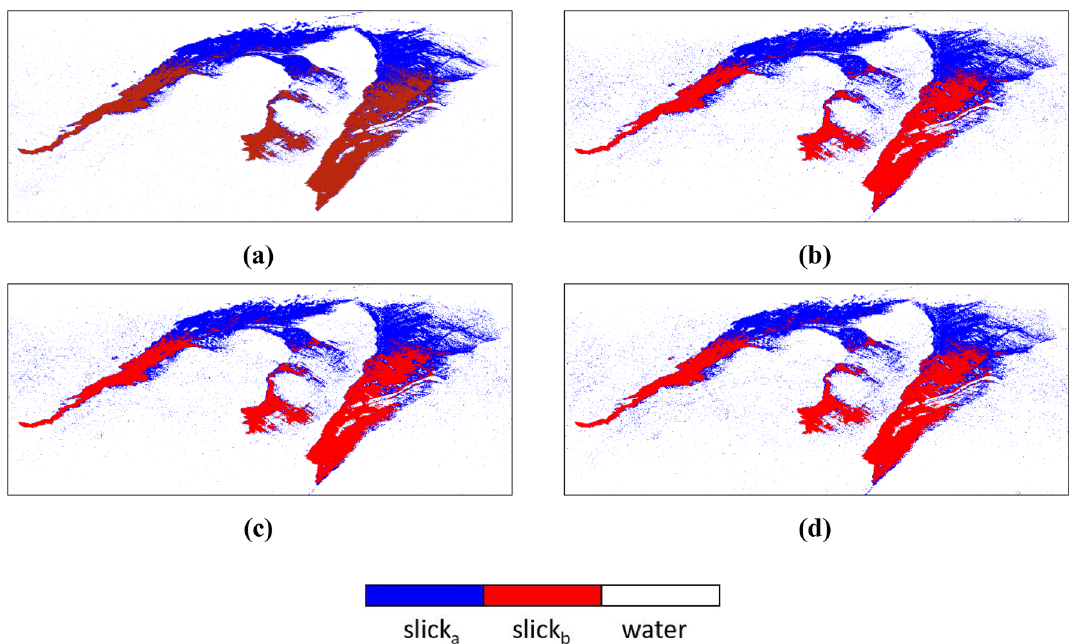
Figure 10. SVM classification results of polarimetric parameters ( a ) Coherency Matrix, ( b ) LHV Compact-pol decomposition, ( c ) LHV Raney decomposition and, ( d ) RHV Compact-pol